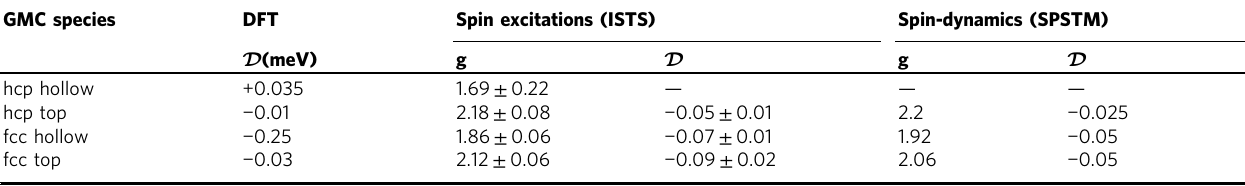
Table 1 Determined values of the longitudinal anisotropy constant D and g-factors